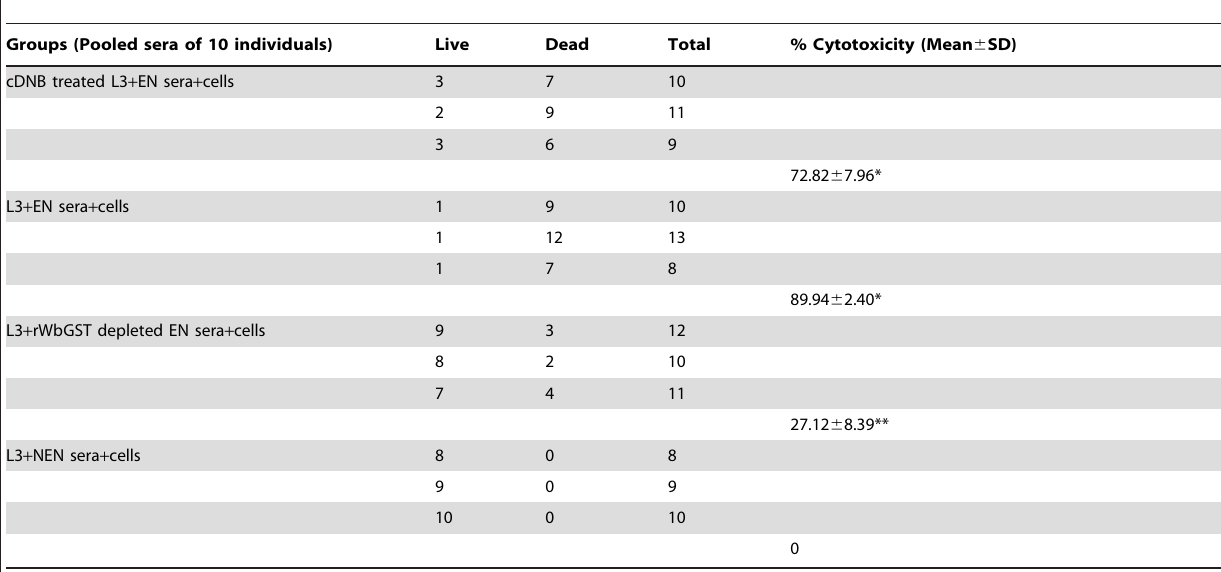
Table 2. Results of antibody-dependent cellular cytotoxicity (ADCC) assay against heterologous B. malayi L3.